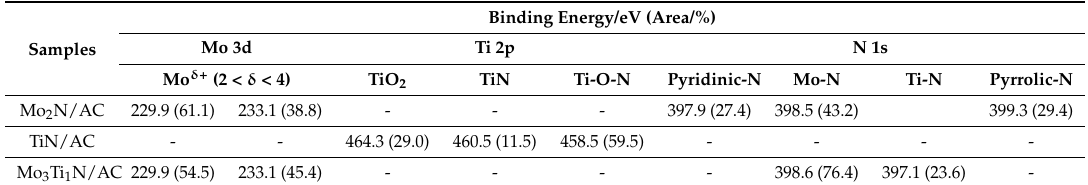
Table 3. The binding energy and relative content of Mo, Ti and N species in the catalysts.